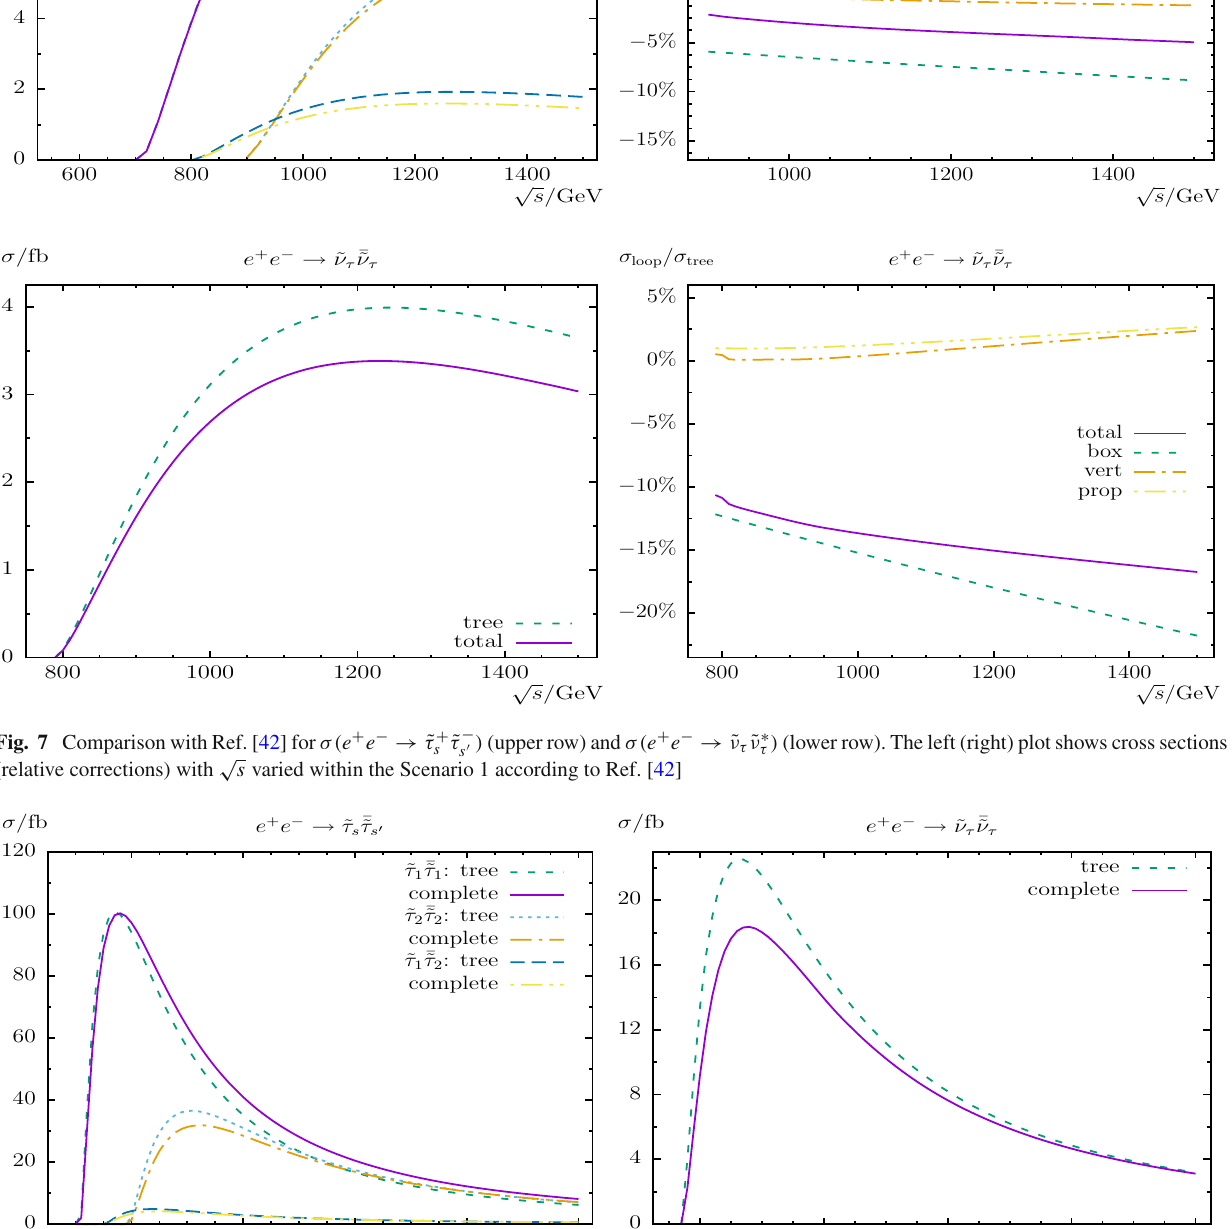
) left plot and σ( e + e − → ˜ ν τ ˜ ν ∗ ) right plot. Tree and complete cross sections are shown τ √ s (cid:3)